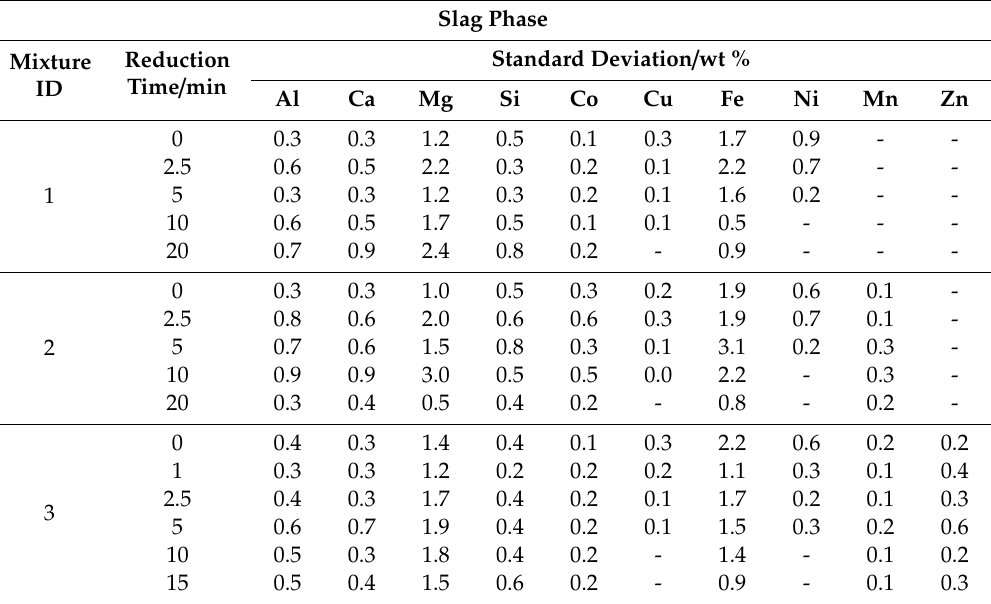
Table A3. Standard deviations (1 σ ) of elemental concentrations in slag.